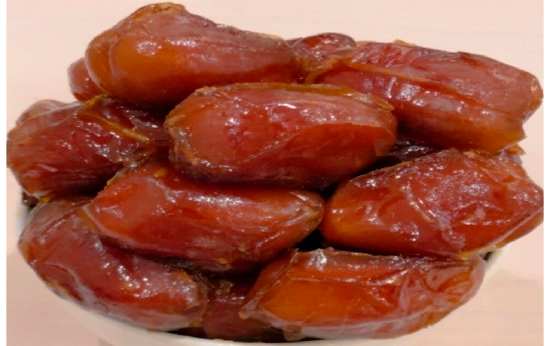
Figure 10. Sample of Al-kelas dates.